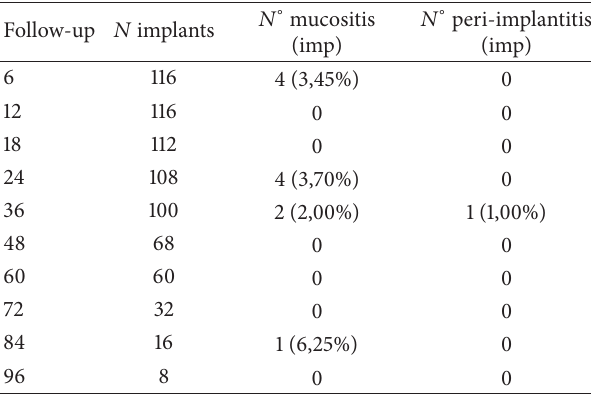
Table 4: Implant-related prevalence in the maxilla.